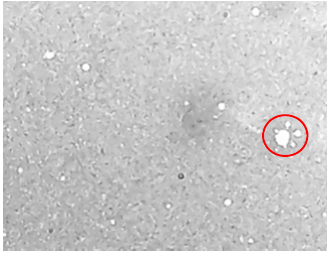
Figure 3. The microstructure of spread kept 37 days at t = – (6 ± 3)ºC.